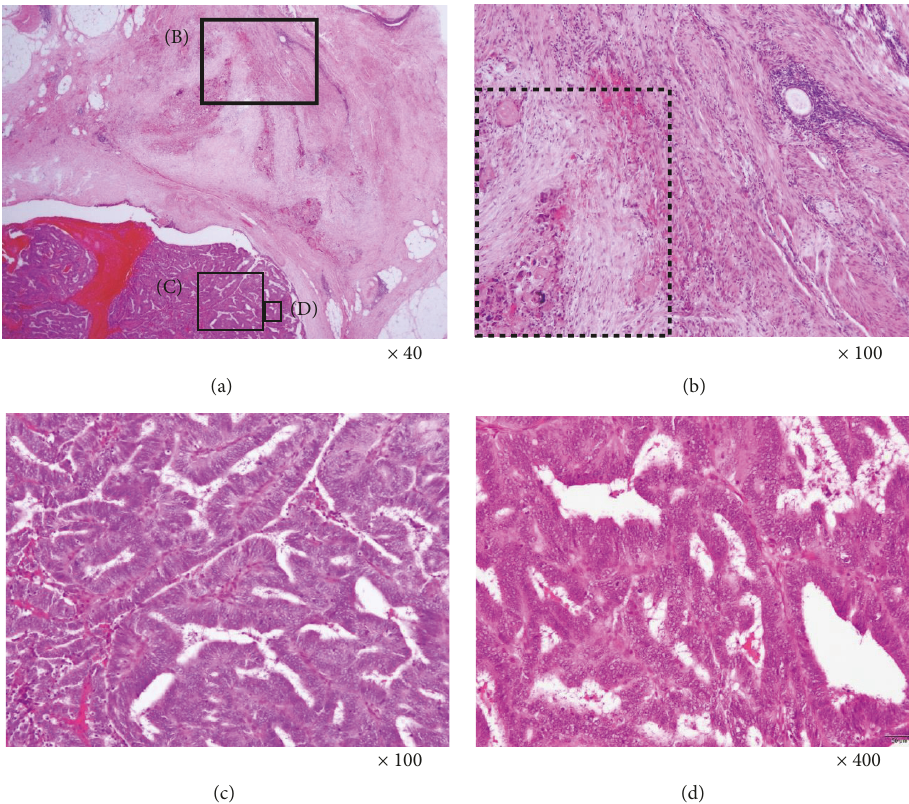
Figure 3: H.E. staining of the tissue diagnosed as the malignant transformation of ureteral endometriosis. (a) The endometrioid carcinoma adjacent to endometriotic tissue was observed (x40). In the photograph (a), the locations of (B) the endometriotic tissue with necrotic tissue found in the dotted area after the chemotherapy (x100), (C) the endometrioid carcinoma (x100), and (D) the atypical endometriosis (x400) were